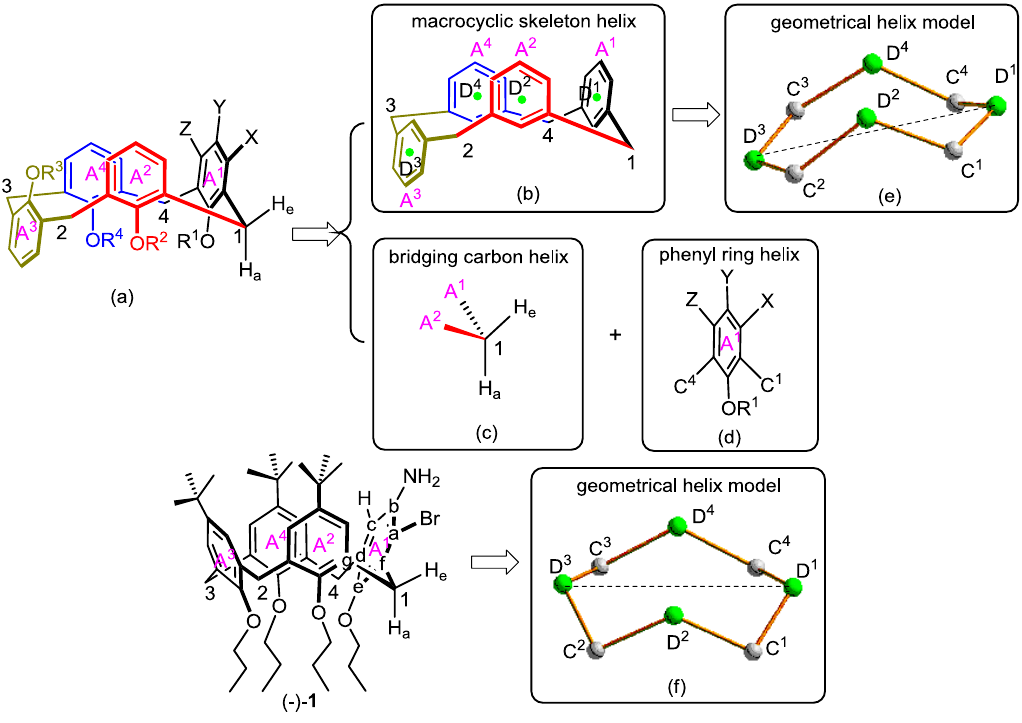
Figure 1. Structural analysis of inherently chiral calix[4]arene and representative inherently chiral calix[4]arene (−)- 1 . inherently chiral calix[4]arene model ( a ); macrocyclic skeleton helix ( b ); bridging carbon helix ( c ); phenyl ring helix ( d ); geometrical helix model of inherently chiral calix[4]arene model ( e ) and geometrical helix model of (−)- 1 ( f ).